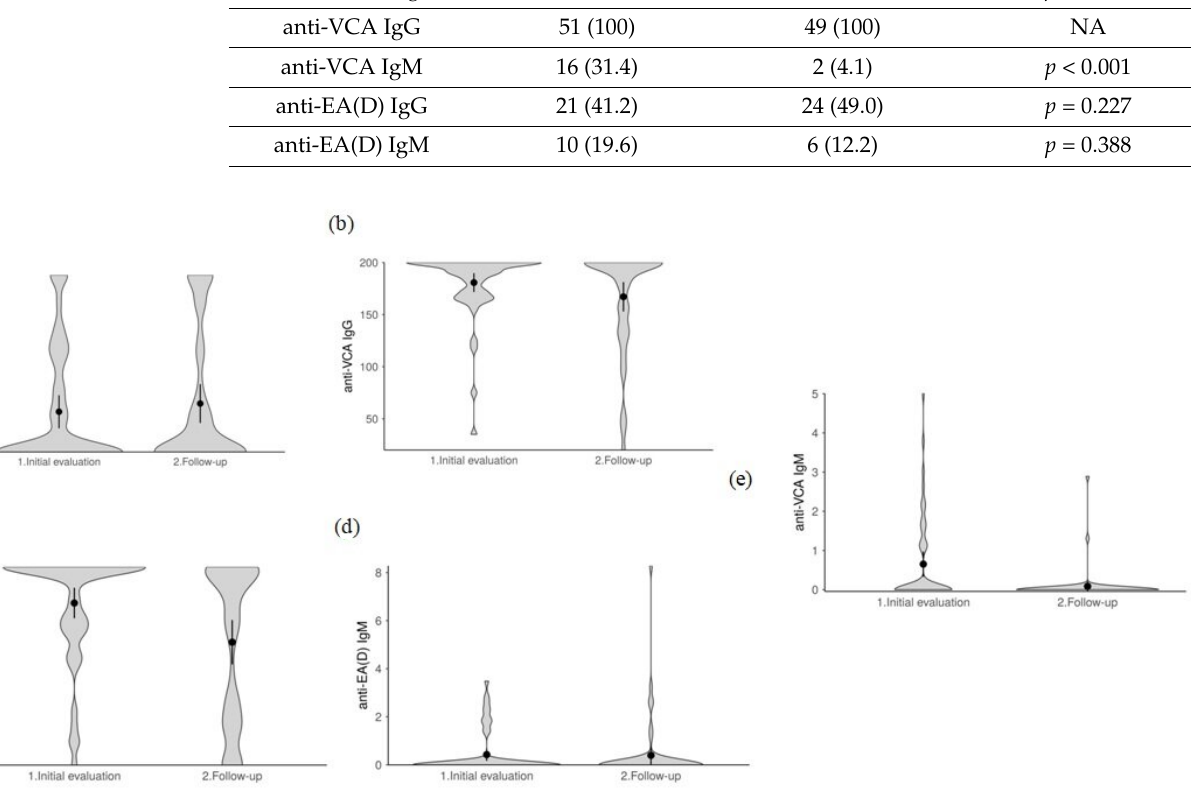
Figure 1. Violin plots for comparison of anti-EBV antibodies’ titer level during the follow up ( a ) anti- EA (D) IgG; ( b ) anti-VCA IgG; ( c ) anti-EBNA-1 IgG; ( d ) anti-EA (D) IgM; ( e ) anti-VCA IgM.